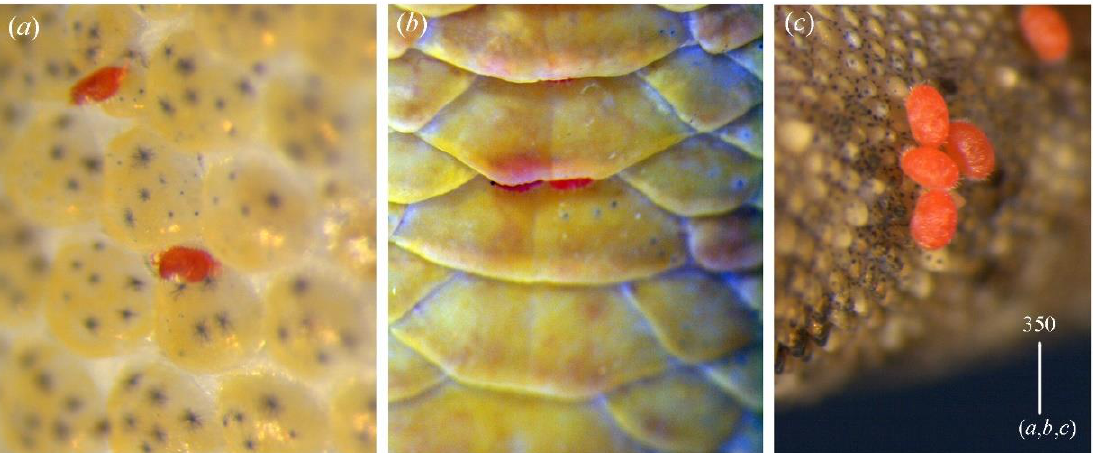
Figure 27. ( a ) Geckobia sp. attached to venter of Hemidactylus frenatus Duméril and Bibron; ( b ) Geckobia brevicephala sp. n. attached to venter scales of a tail of H. frenatus; ( c ) Geckobia mysoriensis sp. n. attached to lateral sides of Cnemaspis mysoriensis (Jerdon).